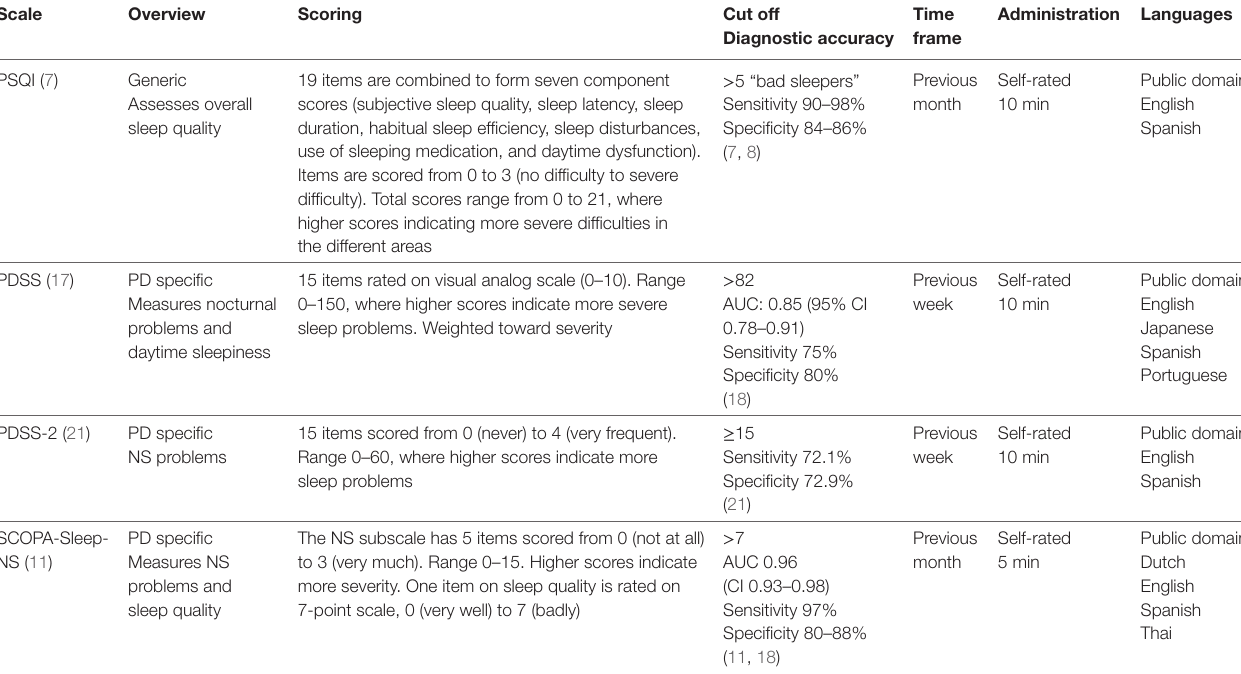
TABLe 1 | Scales that evaluate insomnia in movement